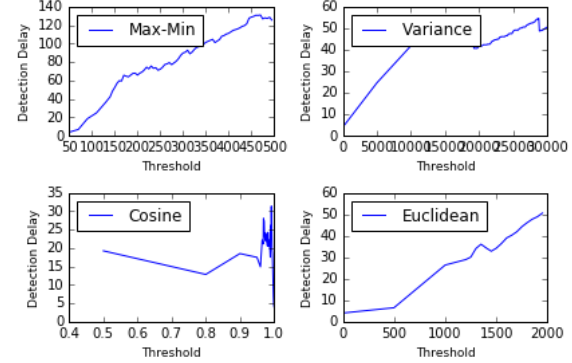
Figure 22. Detection delay of different detector on PU anomaly (in